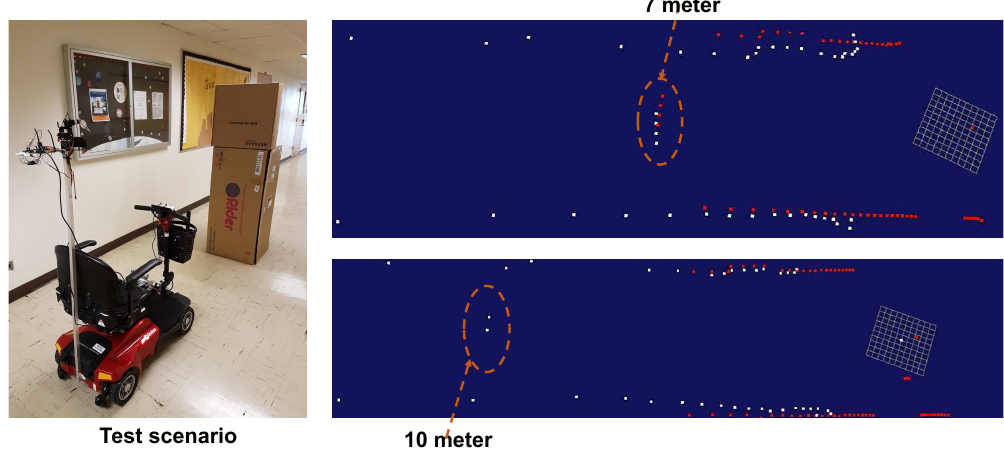
Figure 10. The object mapping experiment when the object is at 7 m and 10 m, respectively.